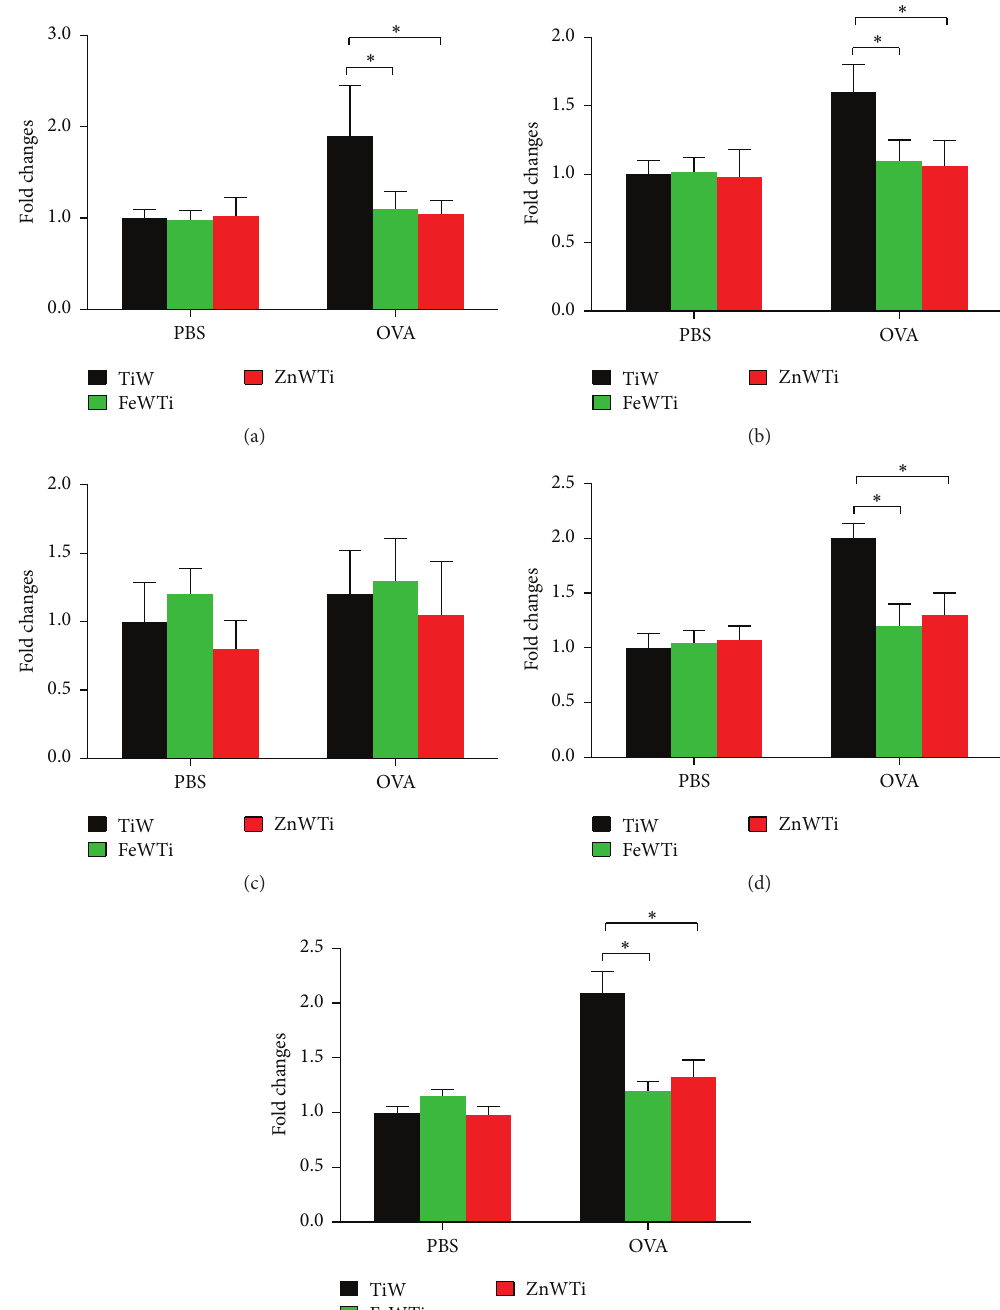
Figure 4: Polyoxometalates FeWTi and ZnWTi reduce mRNA expression of inflammatory cytokines in OVA-induced asthma. The mRNA expressions of cytokines of lung tissues were measured by q-PCR; the expression of (a) Il4 , (b) Il5 , (c) Ifng , (d) Il13 , and (e) Tnf ; bars = SEM; 𝑛 = 7 mice/group/experiment; ∗ 𝑝 < 0.05 compared to mouse treated with TiW. Data are representative of 3